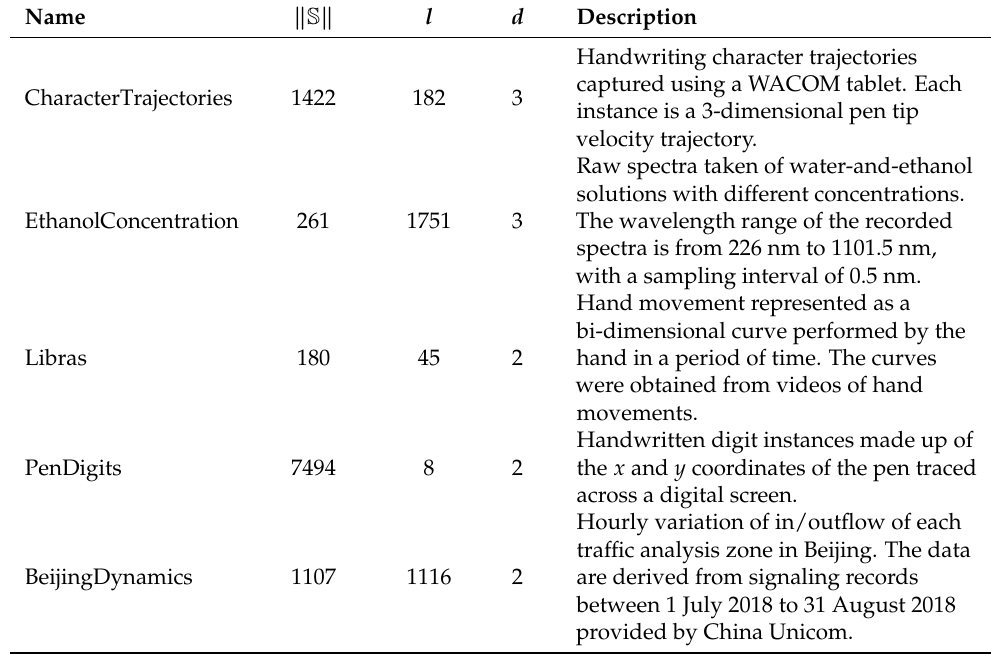
Table 1. Descriptive information of the datasets for